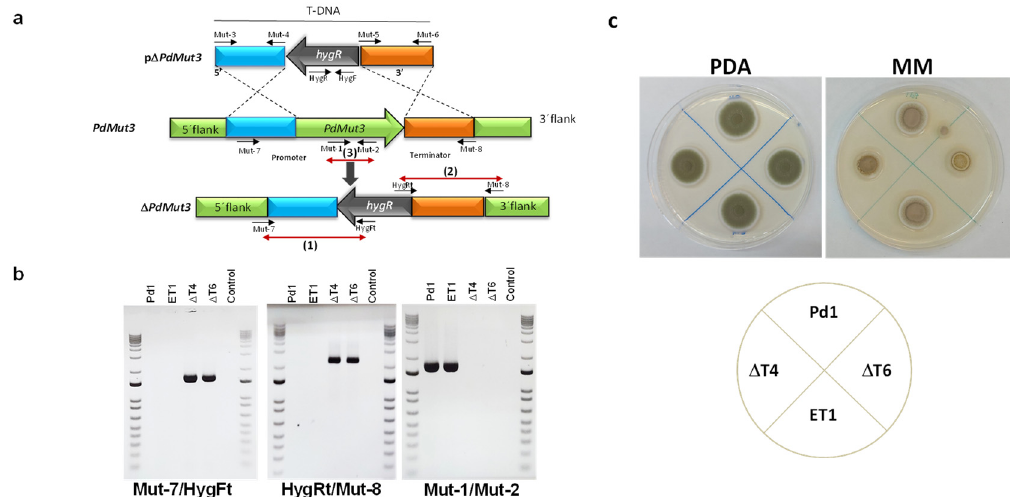
Figure 2. ( a ) Diagram of wild-type locus and the PdMut3 replacement with the HygR selectable marker from p ∆ PdMut3 by homologous recombination to generate the ∆ Mut3 mutants. Red arrows define PCR fragments used for mutants’ confirmation ( b ) Polymerase chain reaction (PCR) evaluation of the wild-type Pd1 strain, two ∆ Mut3 null mutants ( ∆ T4, ∆ T6), and the respective ectopic mutant (ET1) with analytic primers. ( c ) Mycelial growth of parental strain Pd1 and mutants in potato dextrose agar (PDA) and minimal medium (MM) during 4 days at 25 ◦ C.